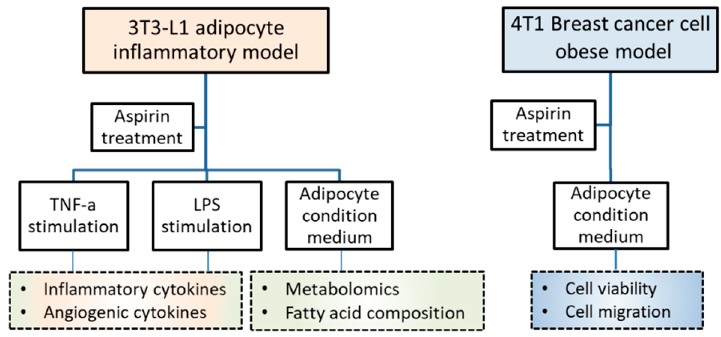
Figure 5. Experimental design and basal conditions.